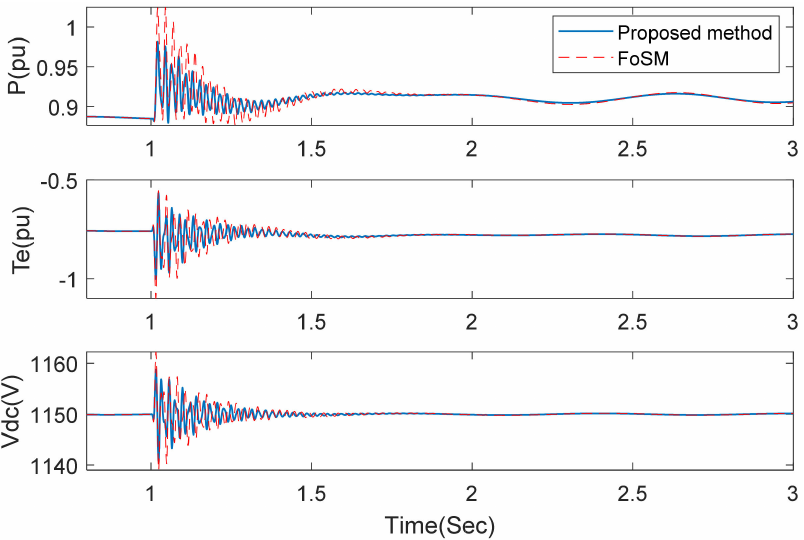
Figure 15. The transient responses of active power, electromagnetic torque, and DC link voltage under both the proposed method and first-order sliding mode